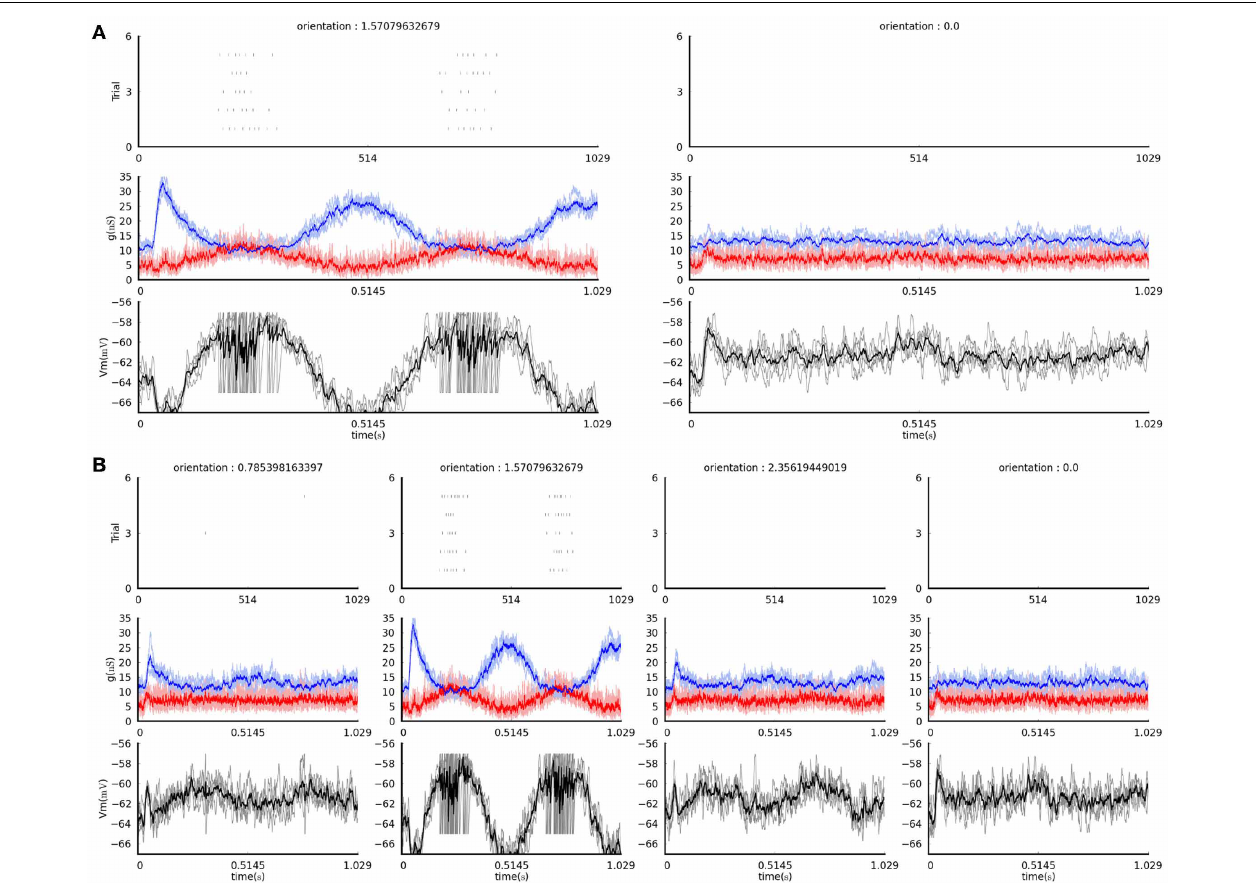
FIGURE 4 | The figures produced by the example visualization commands in section 4.4 (see text). (A) The result of the first command, plotting only the data acquired during presentation of vertically and horizontally-oriented gratings. (B) The result of the second command, plotting data acquired during presentation of all grating orientations (four, in this case). In both plots, each column shows recordings in response to a grating of the orientation indicated at the top. The top panels show the spike rasters